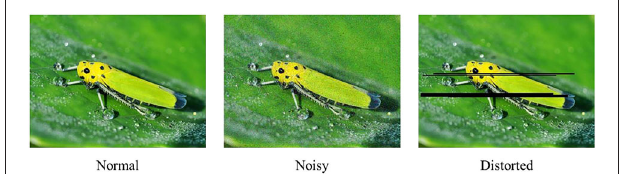
FIGURE 2 | Images with different visual qualities.